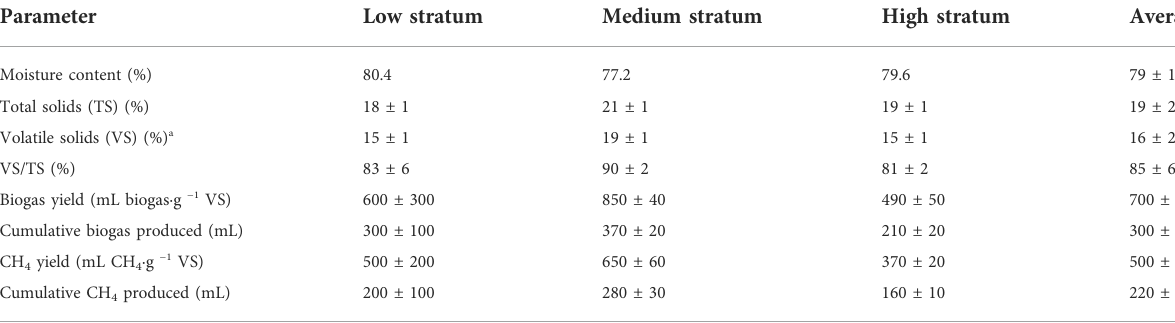
TABLE 2 Chemical characteristics and gas (biogas and CH 4 ) production of the OFMSW for each socioeconomic